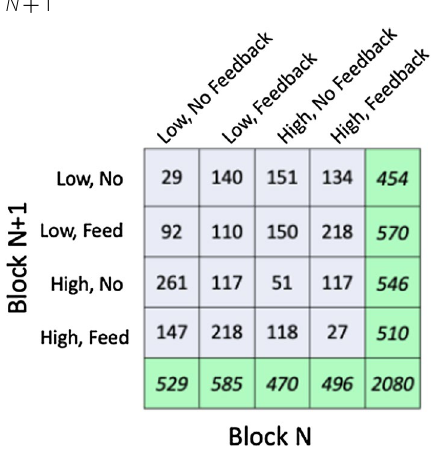
Table 5 Counts of the 16 different pairs of Block N and Block